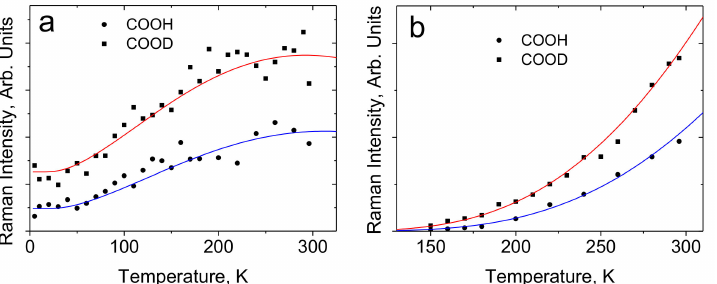
Figure 30. ( a , b ) Temperature dependence of the integral intensity of ~100 cm − 1 mode ( a ) and ~90 cm − 1 mode ( b ) in normal IB (H) and deuterated IB (D) crystals. The ∆ E value is 80 meV for IB (H) and 70 meV for IB (D). More details in